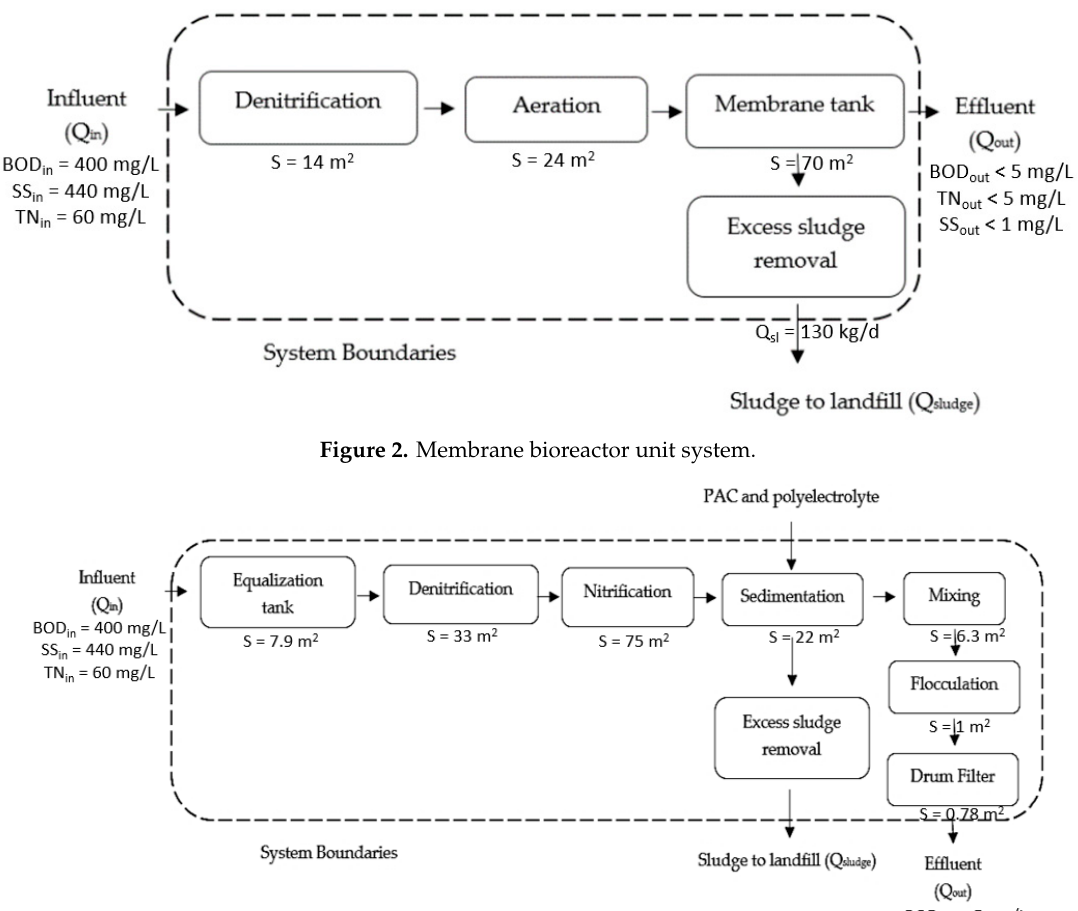
Figure 3. Conventional activated sludge unit system.